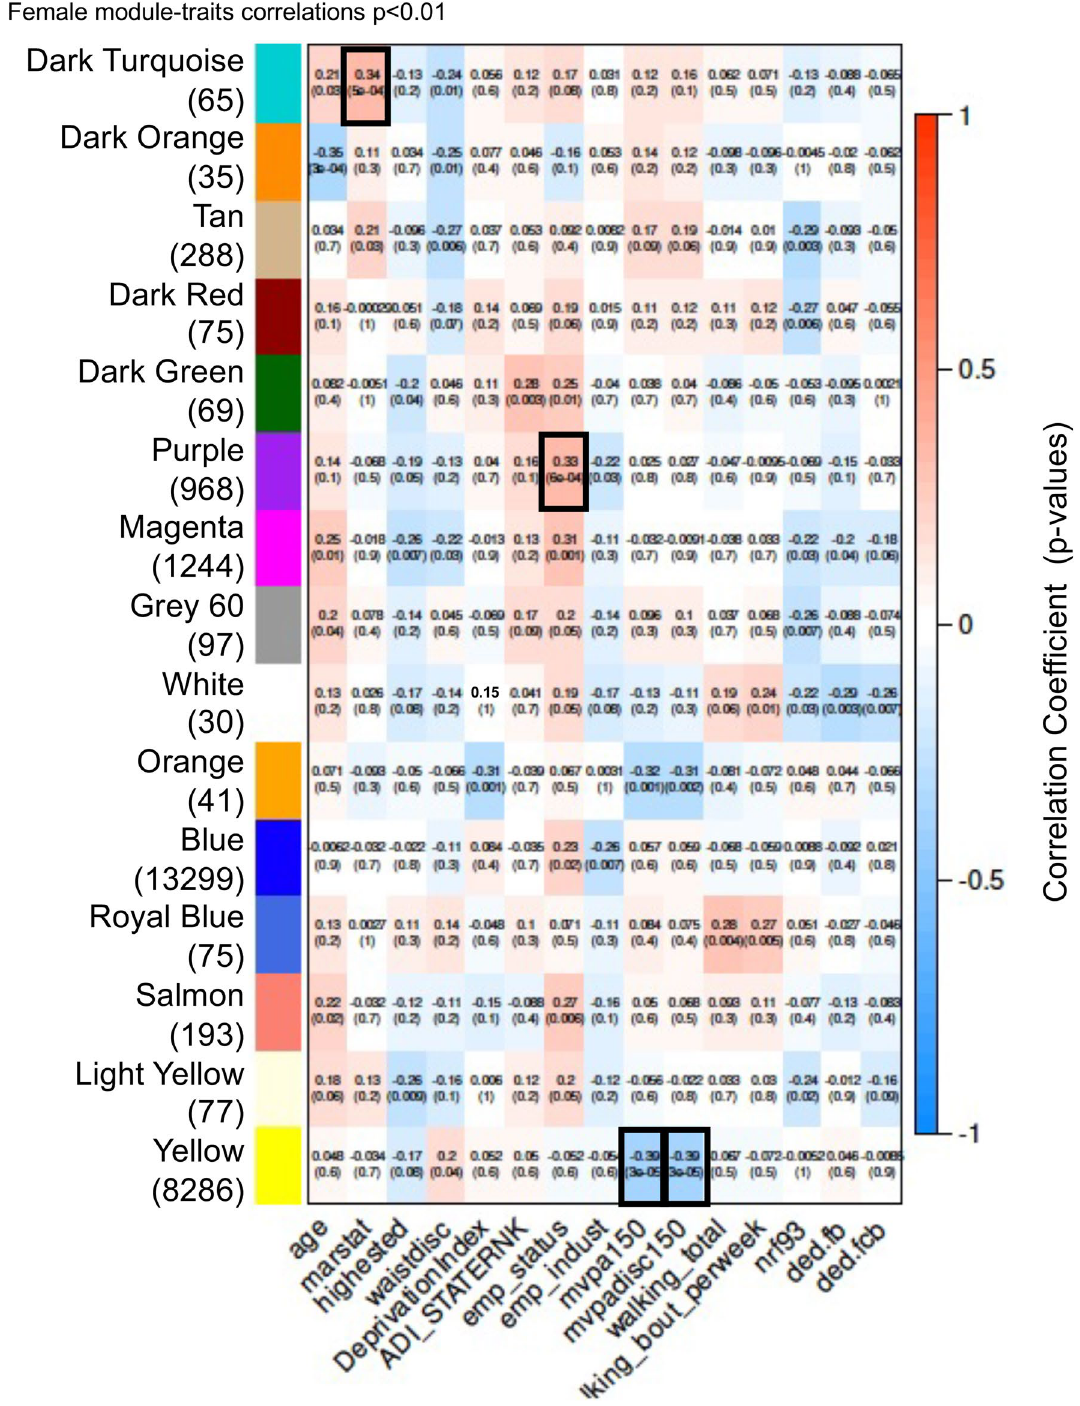
Figure 7. Female module-traits correlations p < 0.001. Rows and columns removed if no correlation met